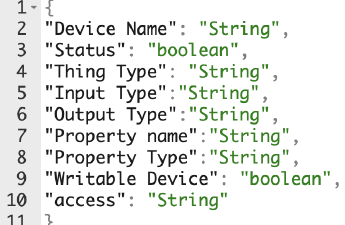
Figure 4. Required JSON for Device addition to TD.